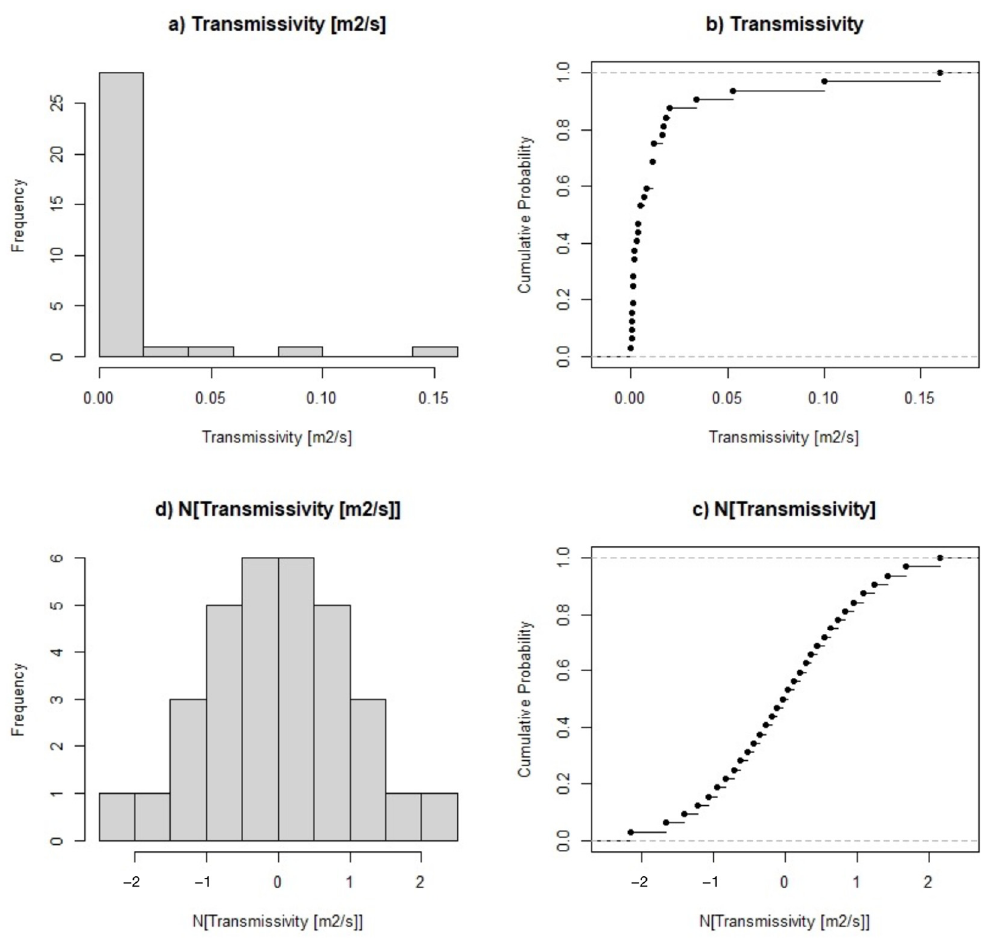
Figure 9. ( a ) Frequency distribution of raw transmissivity values; ( b ) cumulative probability plot of raw transmissivity values; ( c ) normal probability plot of normal scores’ transformed values of transmissivity; ( d ) frequency distribution of normal scores’ transformed values of transmissivity.